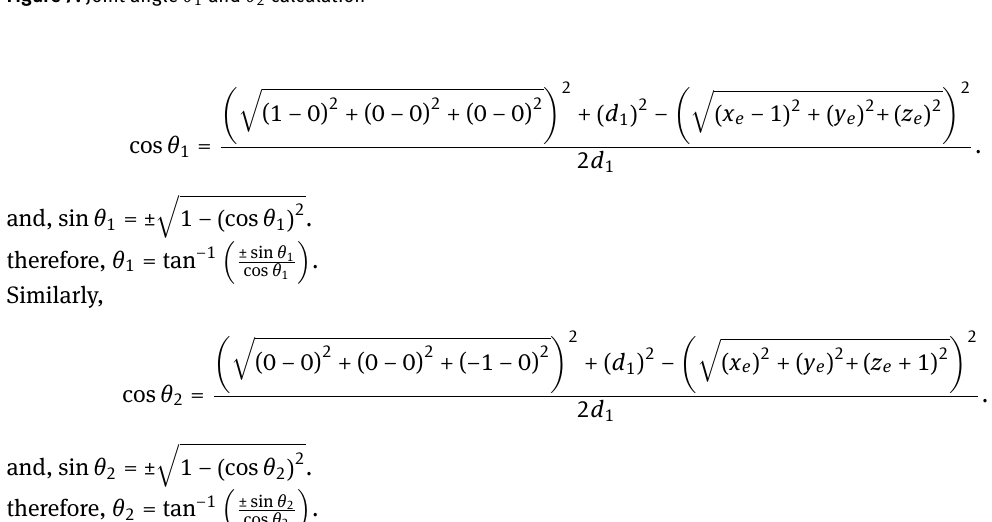
Figure 7: Joint angle θ 1 and θ 2 calculation